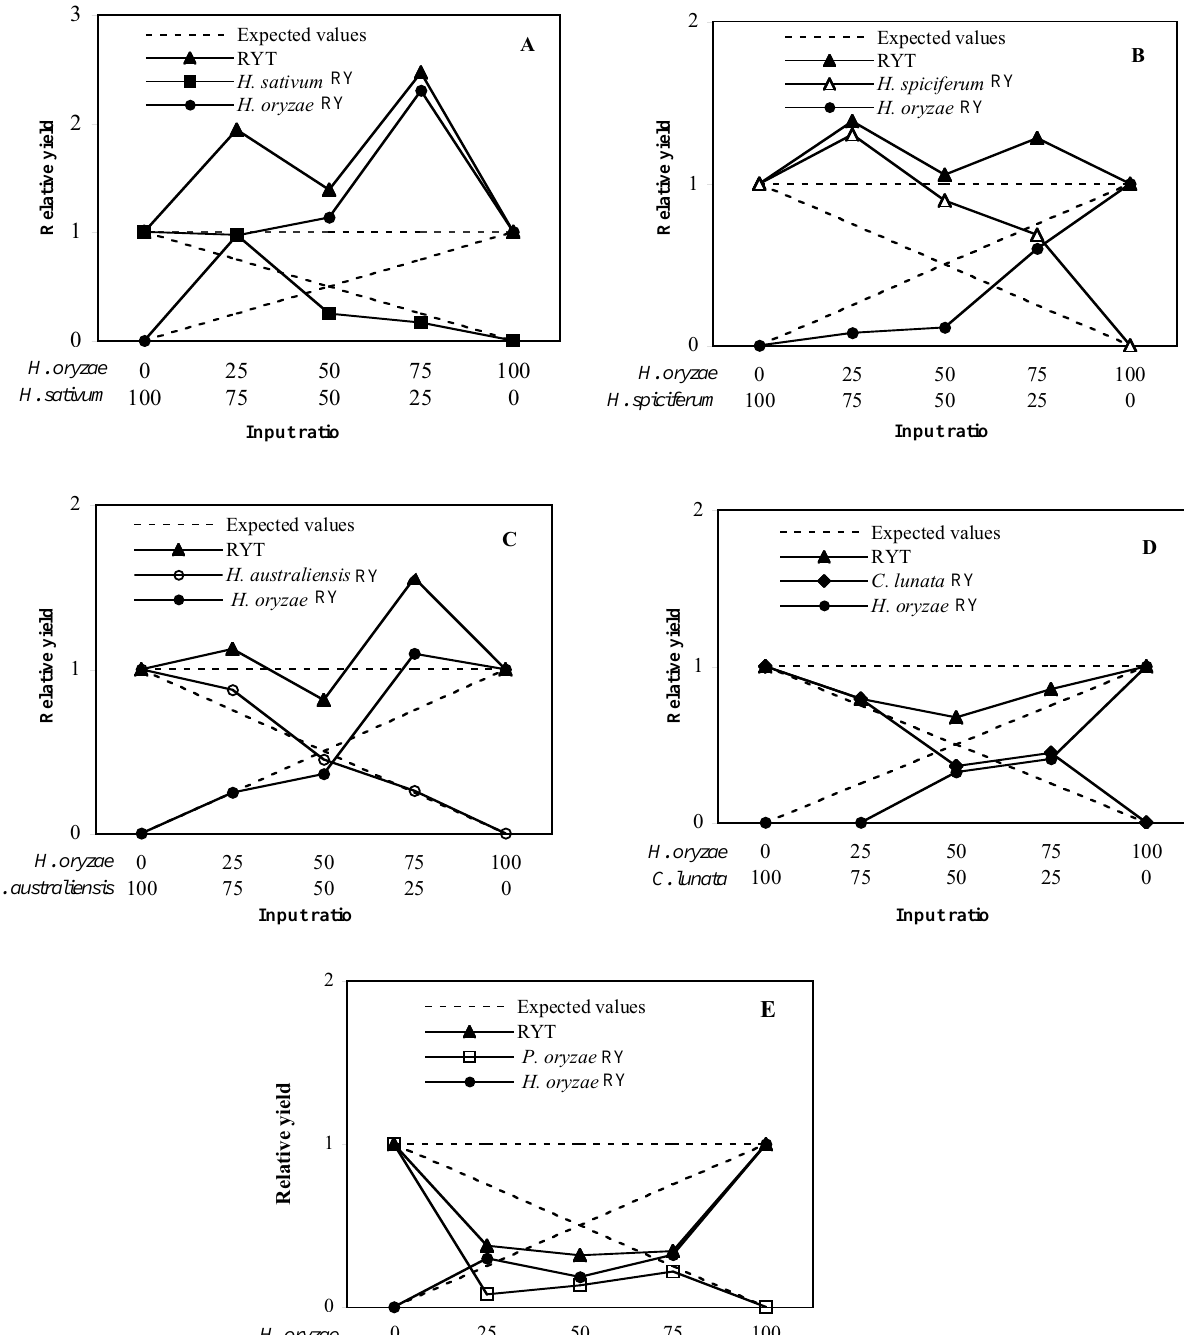
Fig. 1. Relative conidia production on rice leaves inoculated with H. oryzae, H. sativum, H. spiciferum, H. austra- liensis, C. lunata, P. oryzae, alone and in combination, resulting from varied input ratio. RYT, relative yield total; RY, relative yield of each species; Expected values (dotted lines) are reference values indicating equal inter- and intraspecific